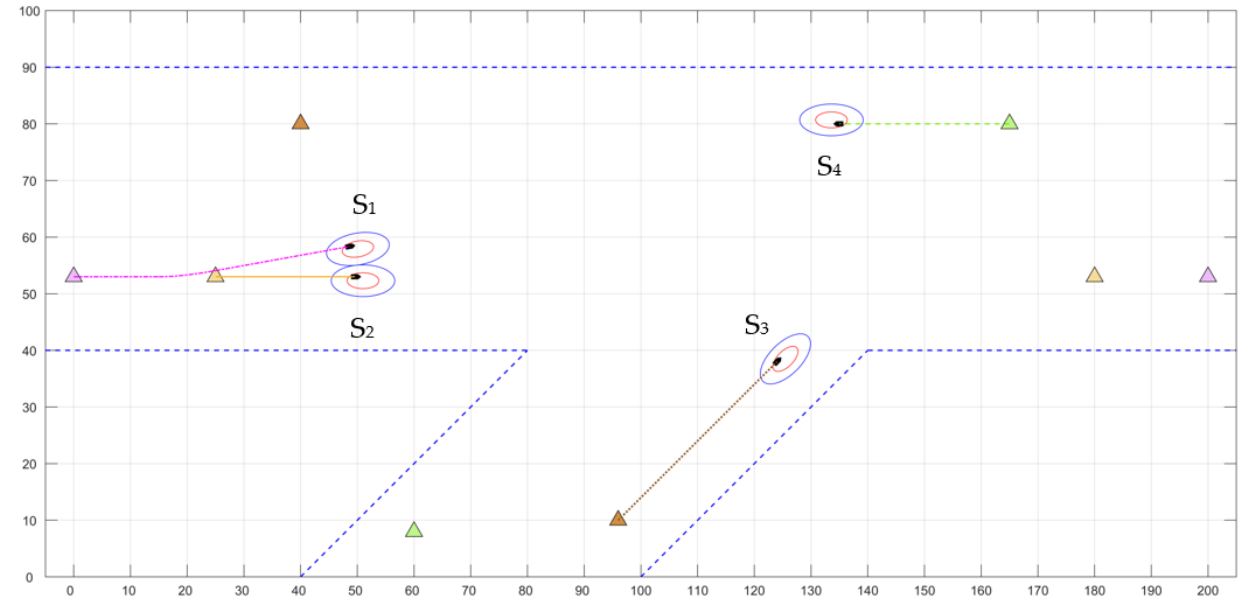
Figure 16. Scenario I of collision avoidance in a multi-ship situation.